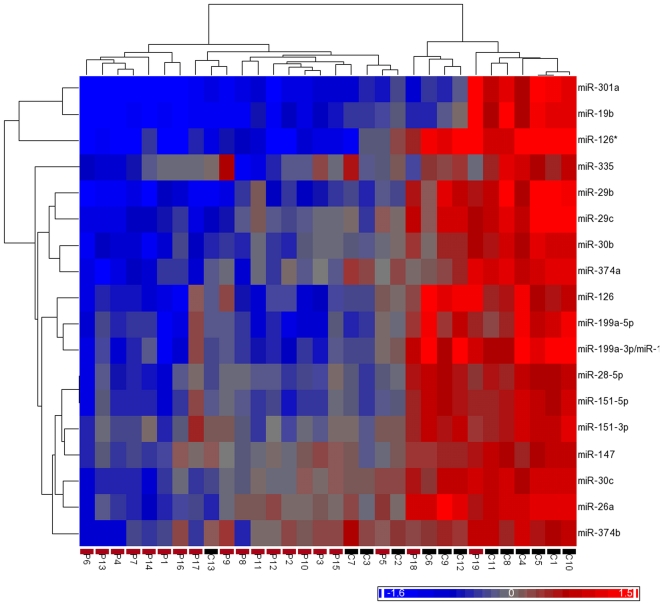
Unsupervised hierarchical clustering of the eighteen differentially expressed miRNAs (rows) for the 32 samples (columns).The sample ID and a heat-map indicating the disease state of each subject in a color code (black for controls and red for cases) are shown at the bottom of the plot. The color scale at the bottom right illustrates the relative expression level of a miRNA across all samples: red represents an expression level above mean, and blue represents expression lower than the mean. The clustering is performed on log2(sample/reference pool) ratios of the 18 differentially expressed miRNAs, using the Euclidean distance function and the average linkage clustering methods.